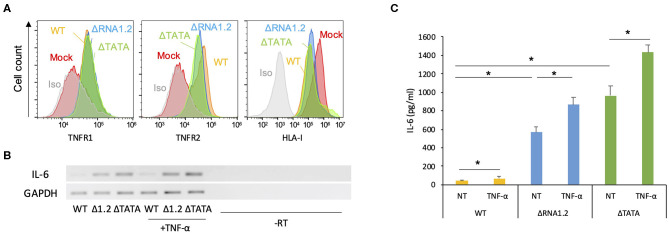
Expression of TNF receptors and IL-6 by RNA1.2 mutant-infected cells. (A) HFFF2 cells were mock-infected or infected with WT, ΔRNA1.2, or ΔTATA at MOI = 5. At 72 h p.i., cell surface expression of TNFR1 and TNFR2 was detected by antibody staining and quantified by flow cytometry. Iso, isotype control of mock-infected cells. Infection of the cells was confirmed by monitoring downregulation of cell surface HLA-I (HLA-A, HLA-B, and HLA-C). (B,C) Levels of IL-6 transcript and secreted protein in RNA1.2 mutant-infected cells. HFFF2 cells were infected with WT, ΔRNA1.2 (Δ1.2) or ΔTATA at MOI = 5. At 72 h p.i., the cells were incubated with fresh medium lacking (NT) or containing TNF-α for a further 6 h. The medium was harvested, and RNA was also isolated from the infected cells. -RT, control lacking reverse transcriptase. (B) RT-PCR data from one of three independent experiments. (C) ELISA data for release of IL-6 into the medium from three independent experiments, each with duplicates. Error bars denote standard error values, and asterisks mark statistically significant differences (p < 0.0001, paired t-test; p < 0.05, Wilcoxon matched-pairs signed rank test).